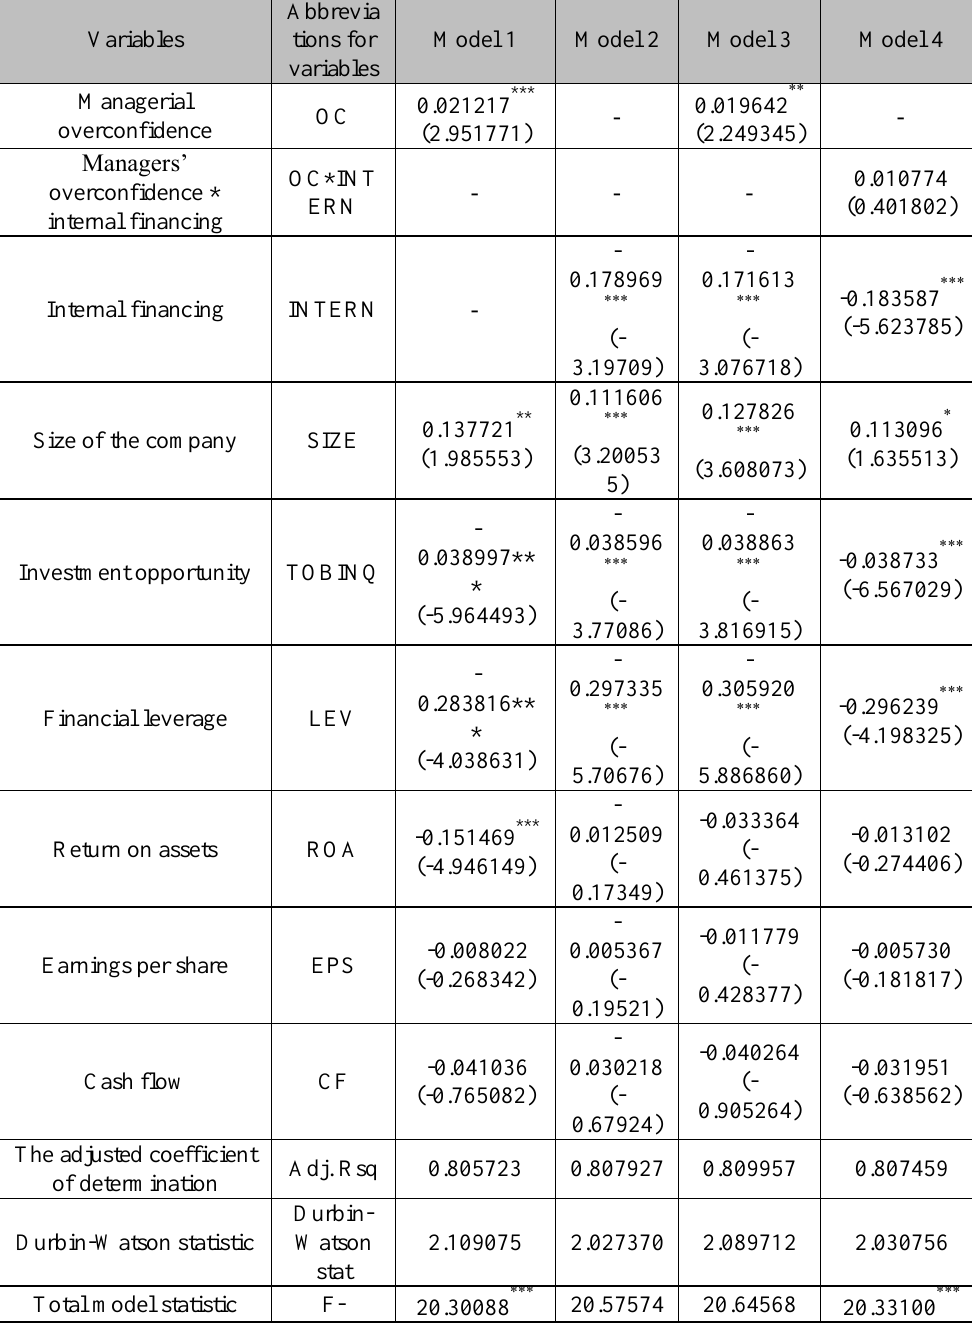
Table 8. Panel data regression test results - investment dependent